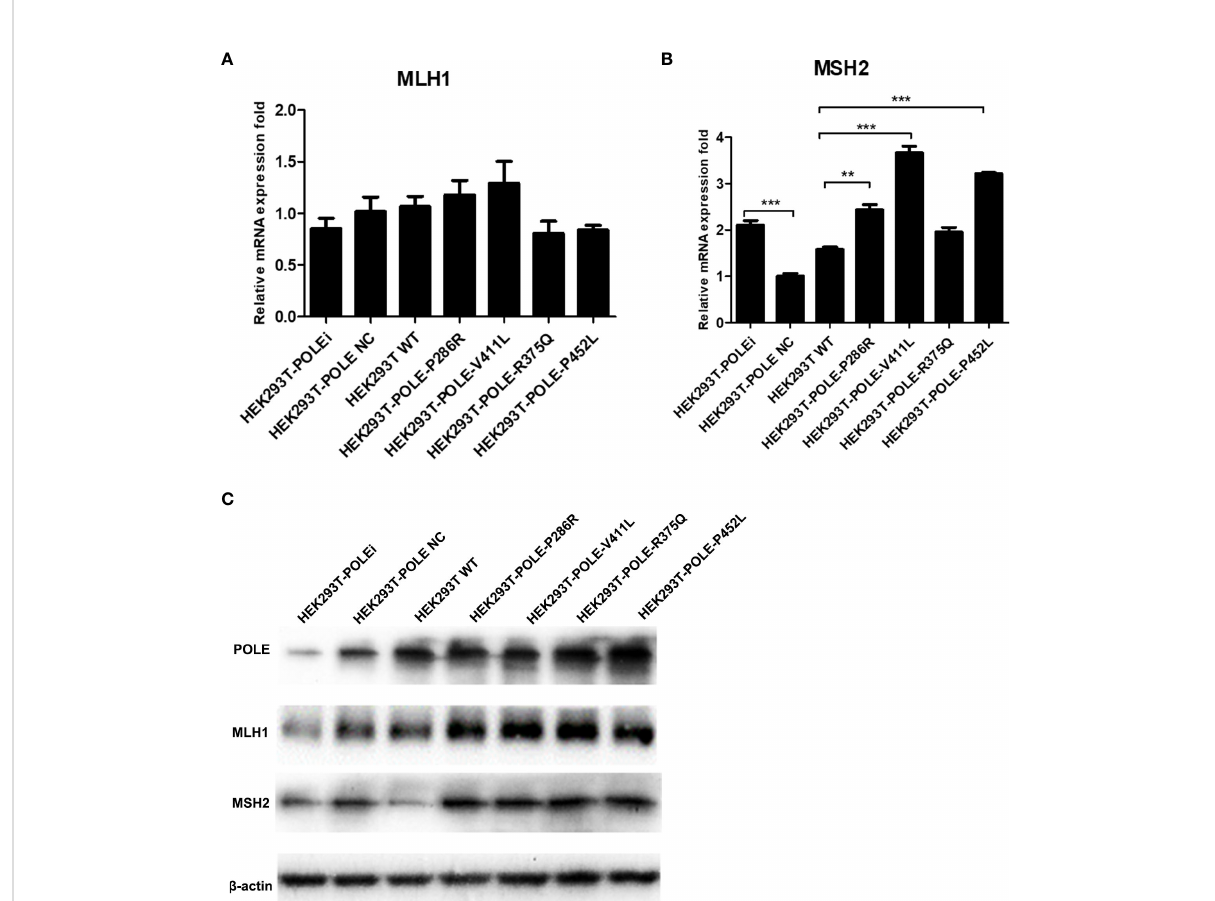
FIGURE 6 POLE EDM upregulated the expression of DNA mismatch repair genes. The stable POLE -knockdown HEK293T cells were transiently transfected with lentiviral vectors expressing wildtype POLE , POLE variants, or negative control. qRT-PCR (A, B) and Western blot analysis (C) were performed to measure mRNA and protein levels of POLE, MLH1, and MSH2. **P<0.01,